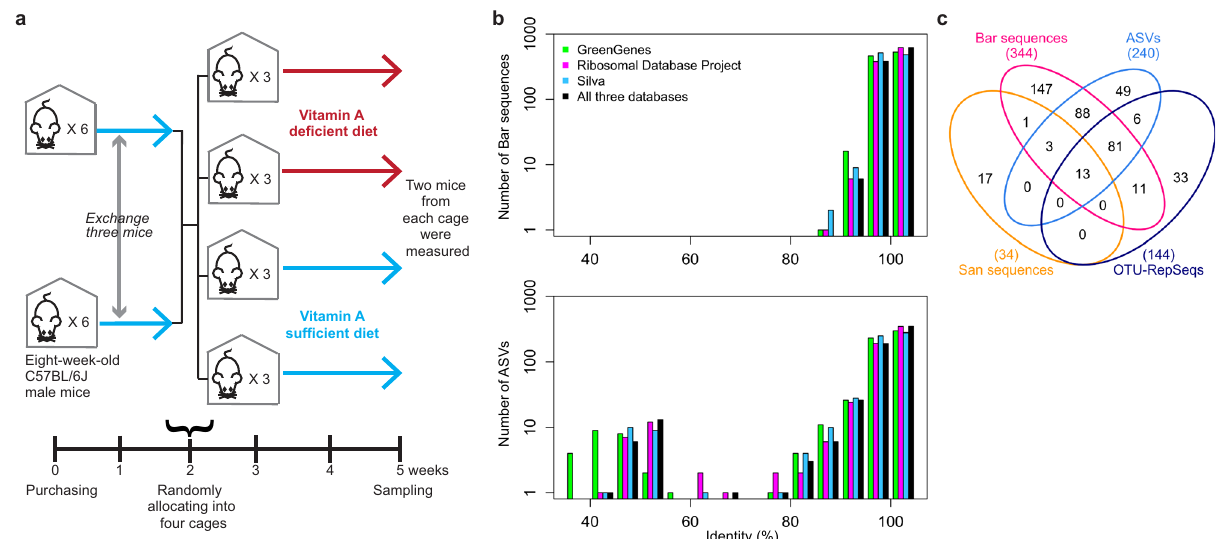
Fig. 3 Dietary vitamin A experimental design and identi fi ed 16S rRNA sequences of the murine cecal microbiotas. a Schematic of the experimental design of the dietary vitamin A experiments (Methods). b Sequence identity pro fi le of Bar sequences and ASVs; identity, the identity between each Bar sequence or ASV and its closest 16S rRNA sequence in three public databases: GreenGenes, Ribosomal Database Project, and Silva. Source data are provided in Supplementary Data 1 and 3. c Comparison (Venn diagram) among San sequences, Bar sequences, ASVs, and OTU-RepSeqs identi fi ed from the cell-sample at the proximal location of the mouse VDd. Numbers, same as Fig.